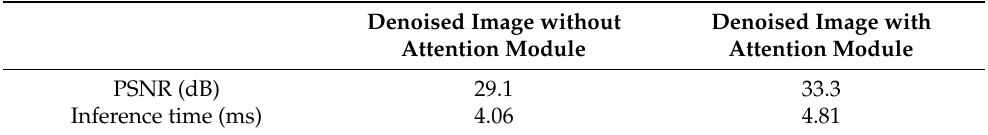
Table 2. Comparisons of the proposed model with and without the attention module on the average PSNR and inference time.